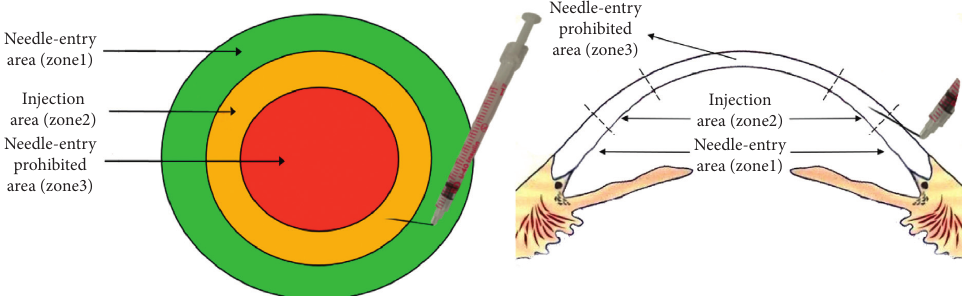
Figure 1: The diagram of TCSI